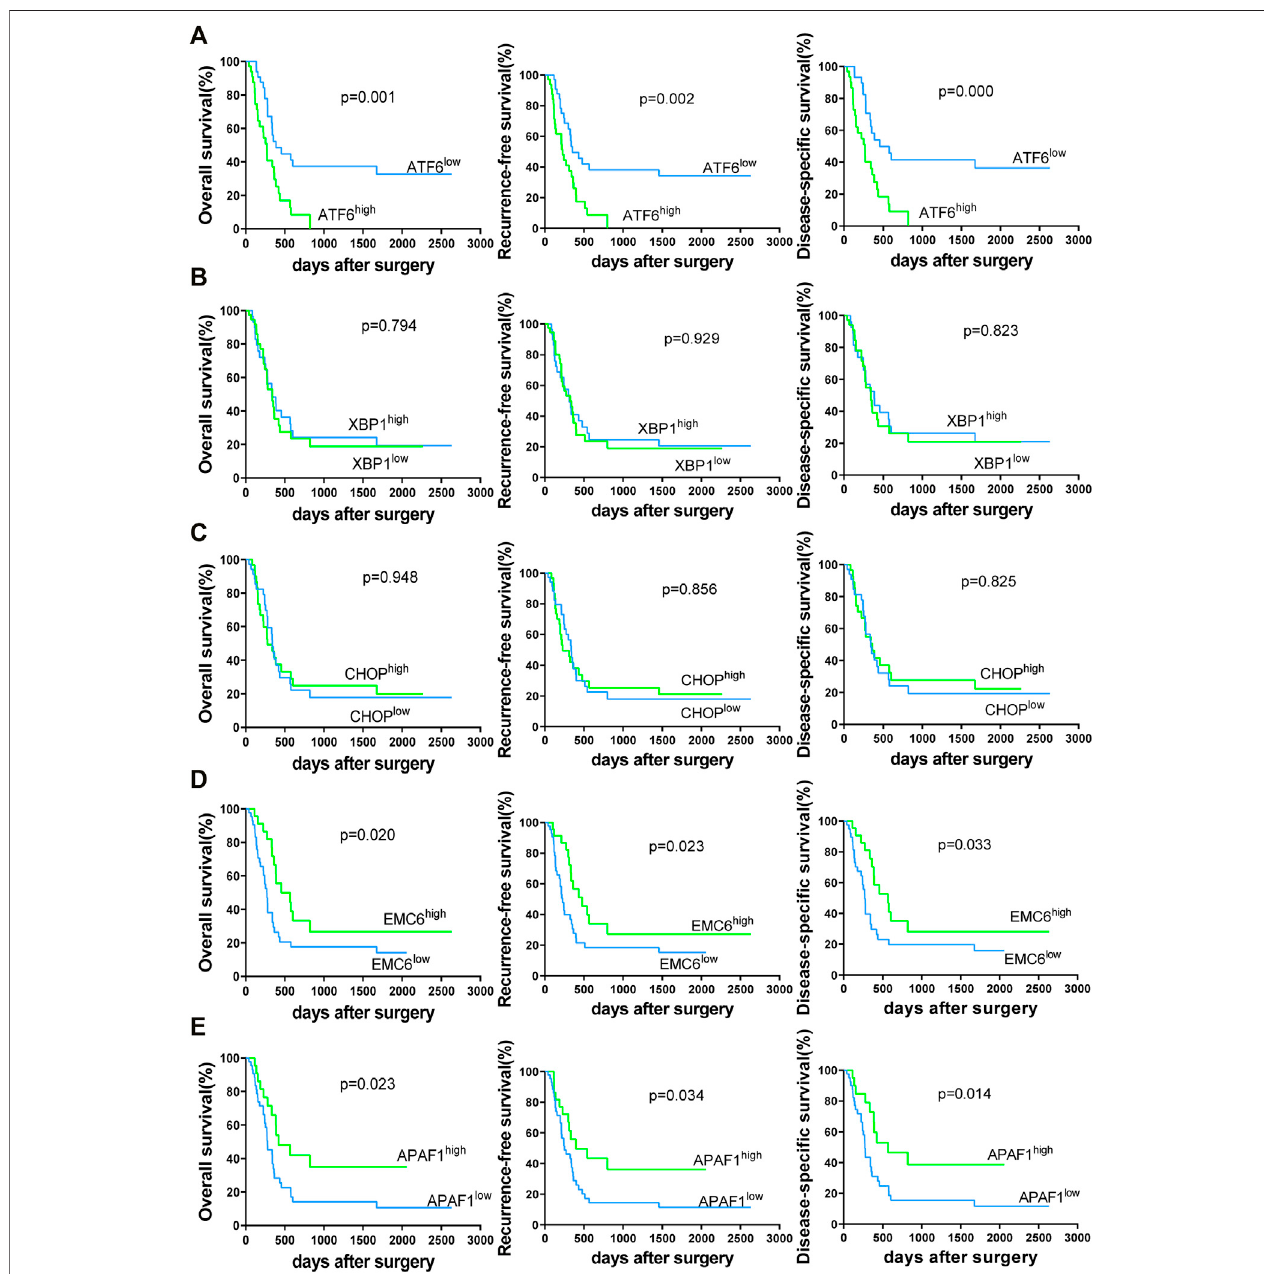
FIGURE 3 | Kaplan – Meier survival curves of 69 PC patients for overall survival (OS), recurrence-free survival (RFS) and disease-speci fi c survival (DSS)-based ATF6 (A) , XBP1 (B) , CHOP (C) , EMC6 (D) , or APAF1 (E) expression. The two-sided log-rank test was performed to compare differences by p